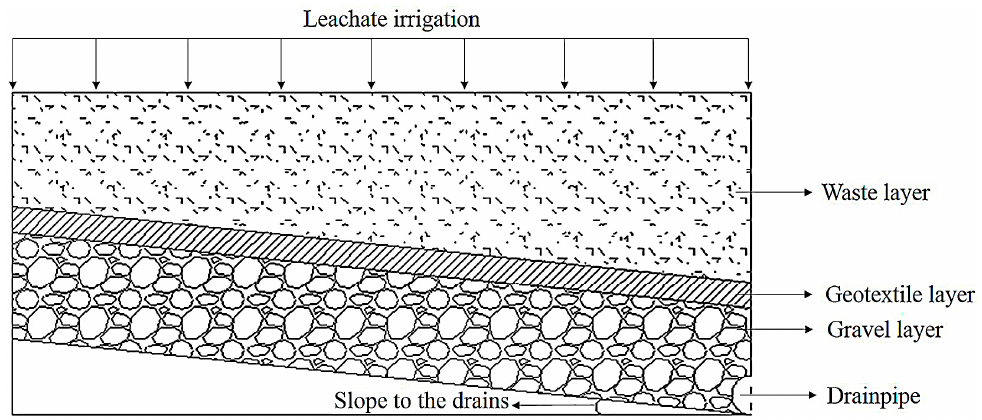
Figure 1. Cross-sectional diagram of the leachate collection system.